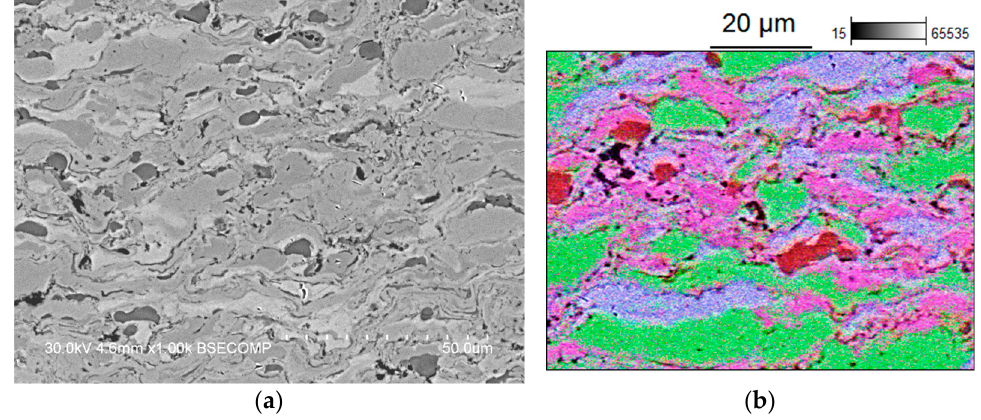
Figure 13. Microstructure (BSE image) of the Fe-Co-Ni-Cu detonation coating ( a ), maps of the elements overlapping an image ( b ). Color in ( b ): red—Fe, purple—Co, green—Ni, blue—Cu. Reprinted from [67], Copyright (2021), with permission from Elsevier.